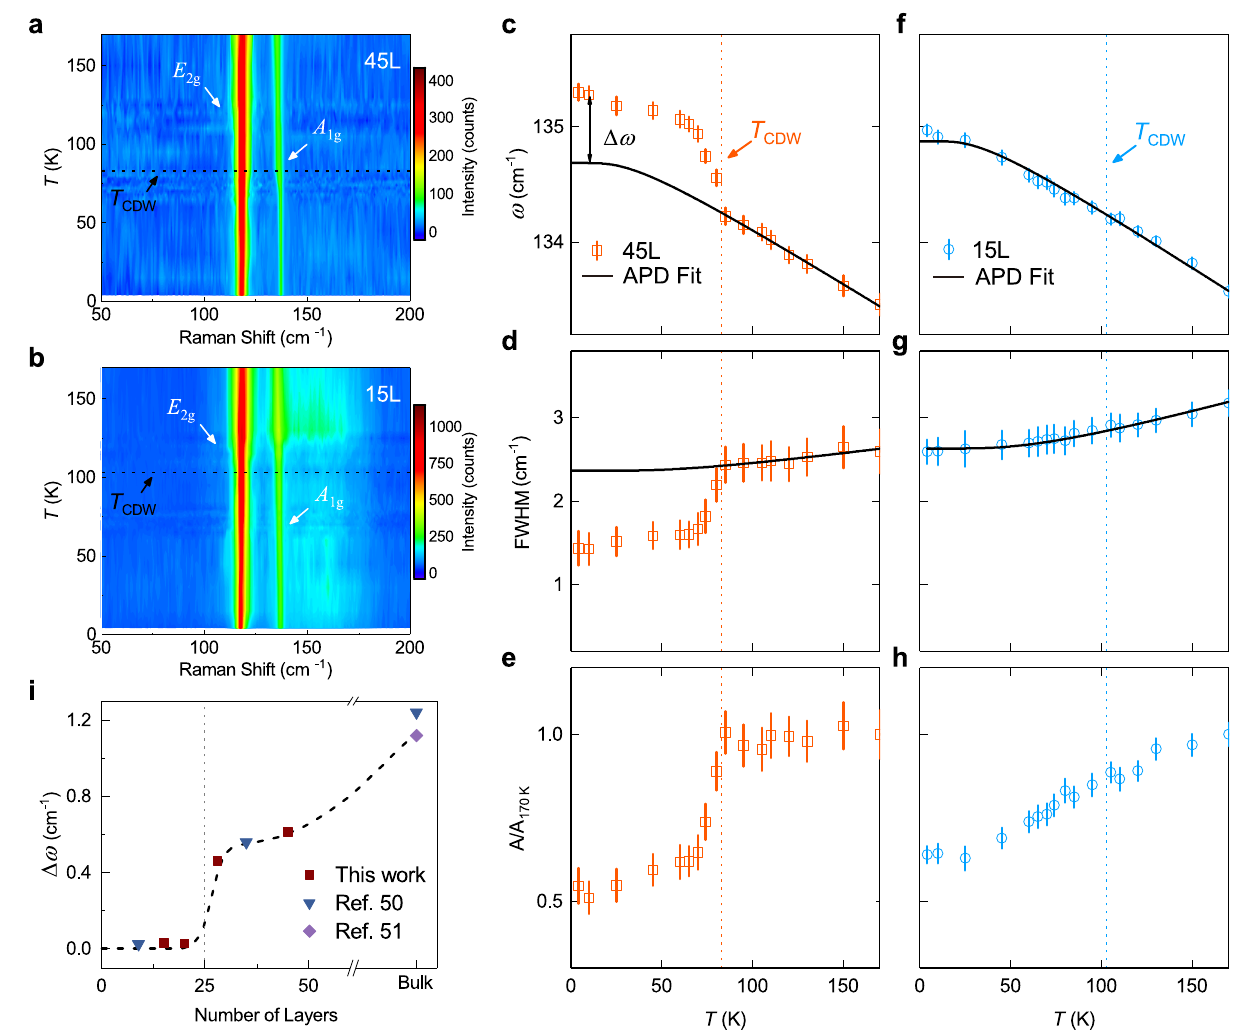
Fig. 3 | Thickness-dependent Raman response of CsV 3 Sb 5 measured in the XX con fi guration. a , b Color contours of E 2g and A 1g modes with the evolution of temperatureforCsV 3 Sb 5 thin fl akeswiththethicknessof45Land15L,respectively. c – h Fitted frequency ( ω ), linewidth (FWHM), and normalized integrated peak intensity ( A / A 170 K ) of the A 1g main lattice phonon for the 45L ( c – e ) and 15L ( f – h )